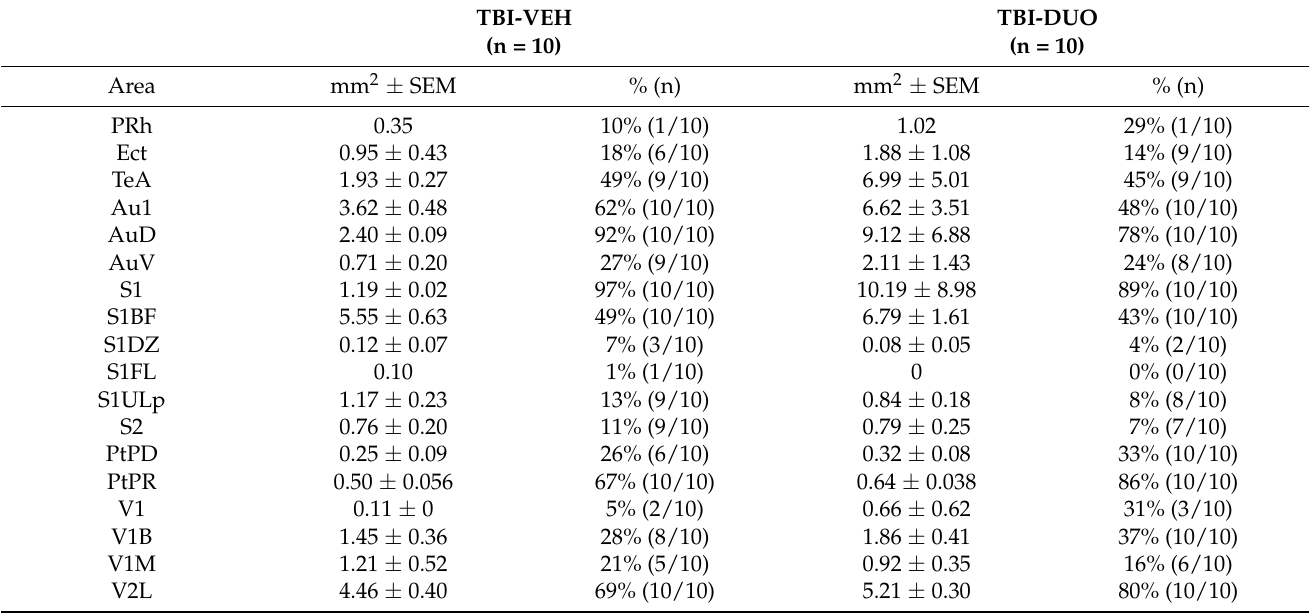
Figure 7. Location and area (mm 2 ) of the cortical lesion. ( A ) Representative thionin-stained coronal sections showing the rostrocaudal extent of the cortical lesion in a rat in the TBI-VEH group on day (D) 14 post-TBI. Arrowheads indicate the mediolateral lesion extent at different bregma levels (bregma –2.40 to –6.36). L1 is the length of the cortical surface from the medial reference point (arrow, cortical contact with the corpus callosum) to the upper edge of the lesion, L2 is the mediolateral extent of the lesion, L3 is the distance from the lower edge of the lesion to the rhinal fissure (arrow). ( B ) Computer-generated unfolded cortical map showing the lesion location on the cortical mantle (violet) from the same animal. ( C ) Cortical lesion of a rat in the TBI-DUO group on D14 post-TBI. ( D ) Unfolded cortical map from the same animal. SFN+NAC duotherapy had no effect on the total lesion area or location (see Table 1). Scale bar equals 1 mm in all panels. Abbreviations: D, day; DUO, duotherapy treated with N-acetylcysteine and sulforaphane; NAC, N-acetylcysteine; SFN, sulforaphane; TBI, traumatic brain injury; VEH, vehicle. For abbreviations, see also Table 1. Table 1. Mean ± SEM area (mm 2 ) and percentage (%) of the lesion area of the total area of the given cytoarchitectonic cortical region. Number of animals with a lesion in a given cortical subfield is in parentheses (n). No difference in lesion area was detected between